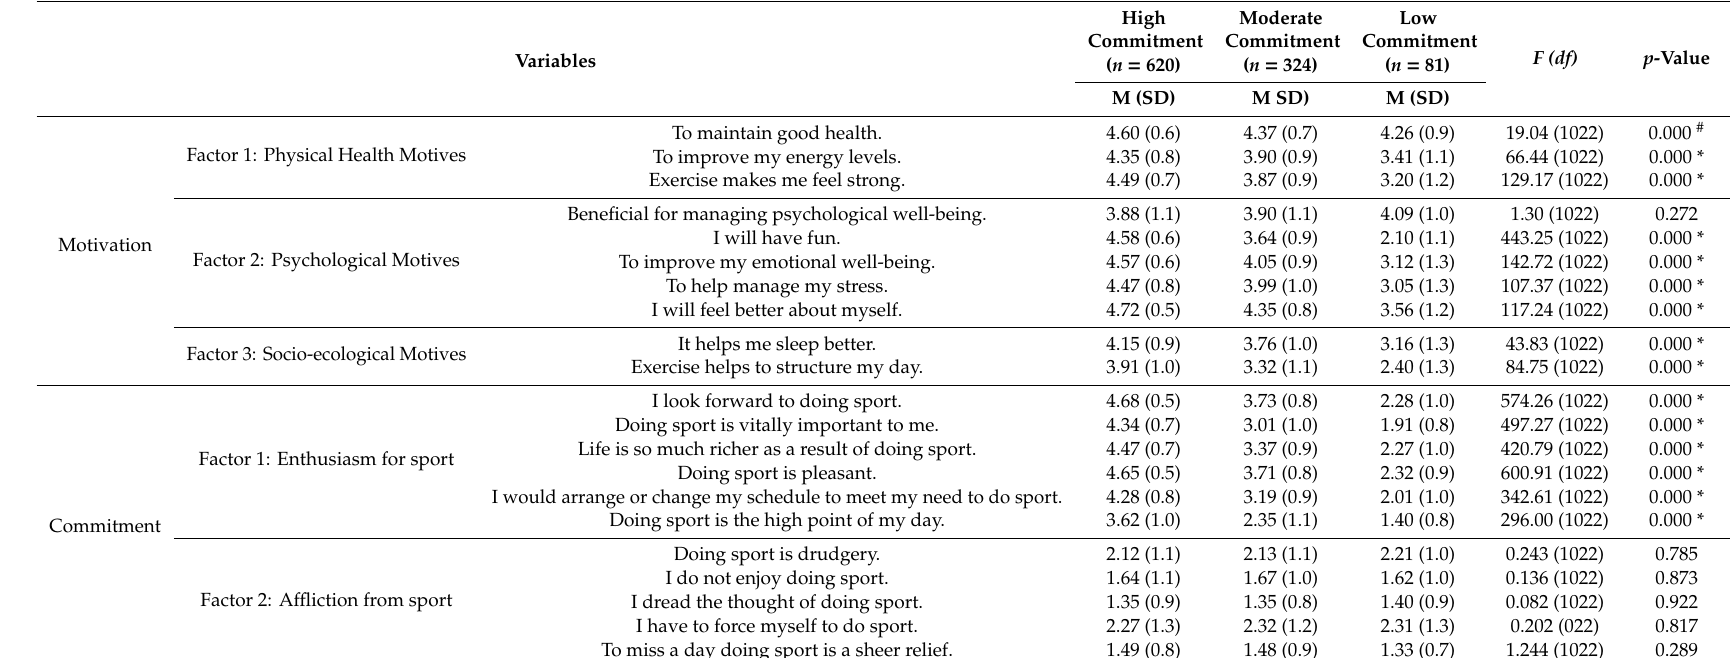
Table 4. Average Motives and Commitment scores in the three